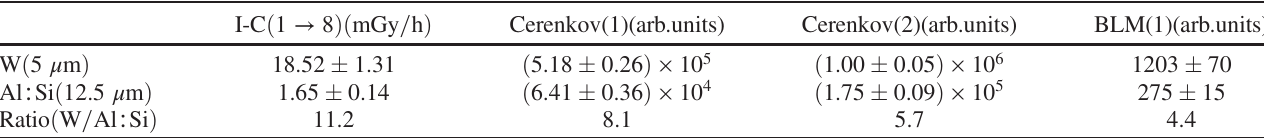
TABLE II. Radiation-dose — averaged over 10 scans and integrated over 30 beam shots — measured in different positions of the FERMI machine when scanning the electron beam — 700 pC at 1.325 GeV — with a 12 . 5 μ m Al ð 99 Þ ∶ Si ð 1 Þ wire and a 5 μ m tungsten wire at a motor speed of 0 . 2 mm = s. The ratio — W against Al ð 99 Þ ∶ Si ð 1 Þ — of the measured radiation-dose is also shown. Absolute and relative measurements of radiation-dose have been performed with different detectors located at different positions of the machine. An absolute measurement of the radiation-dose rate (mGy = h) released on the FEL1 undulator chain is obtained by a set of 8 Ionization- Chambers (I-Cs) located in front, behind and in between the 7 undulator composing the FEL1 undulator chain. A relative measurement of the radiation-dose release in the FEL1 undulator chain is also obtained by means of 2 Cerenkov fibers — Cerenkov(1,2) — which are stretched along the FEL1 vacuum chamber. Finally, a further relative radiation-dose measurement is achieved by means of the scintillator fiber — BLM(1) — placed at 2.48 m from the WSC.